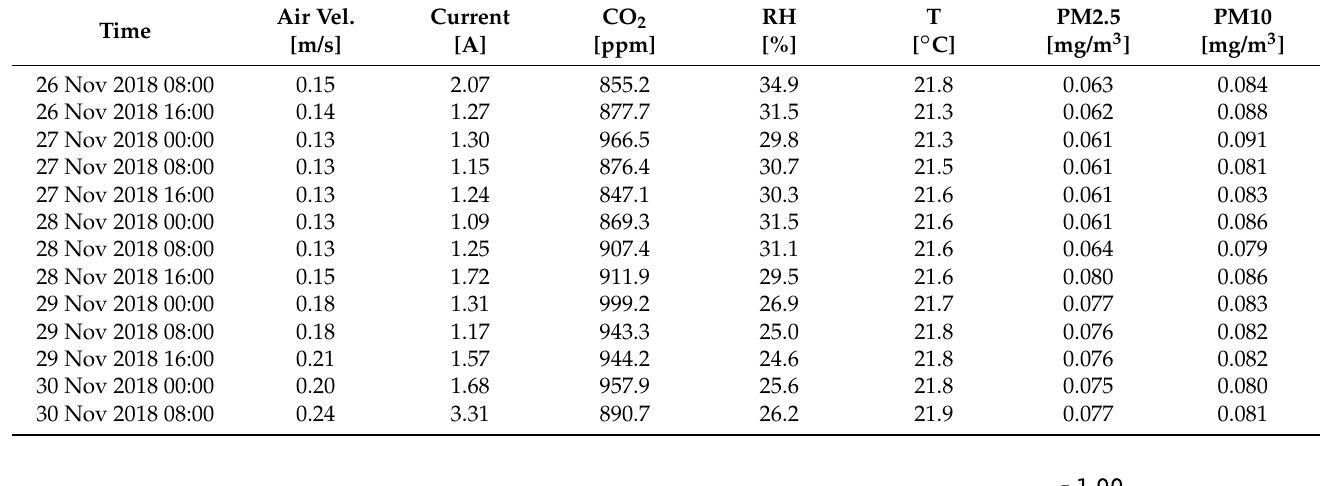
Table 4. 8-h average values of the field data measurements.